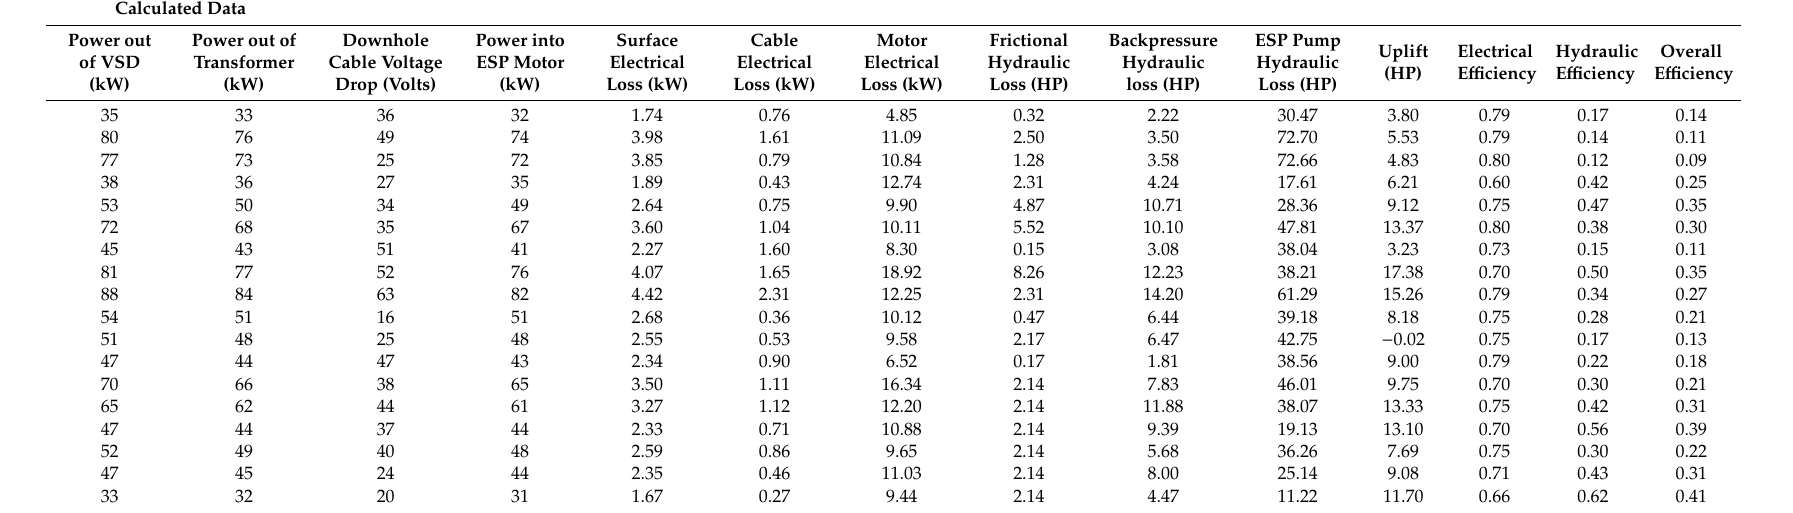
Table A4. Calculated data for detailed ESP system energy